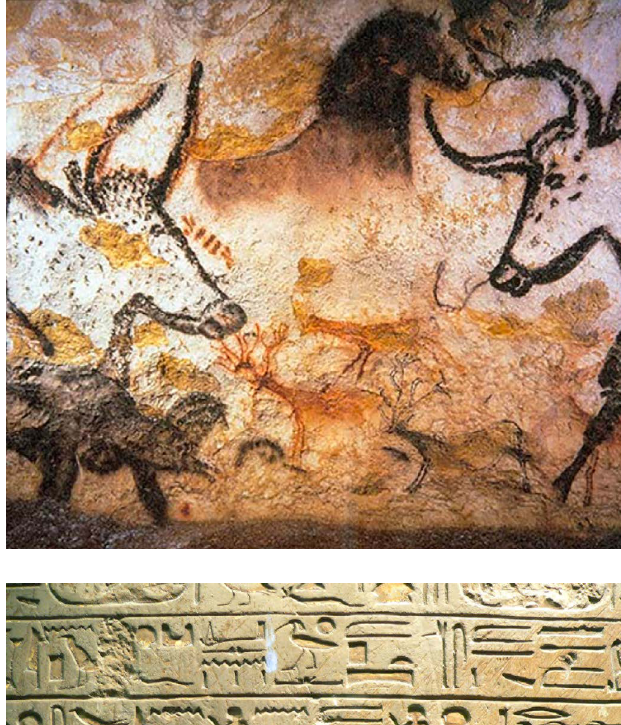
Fig. 1 Wall paintings, 15,300 BC,